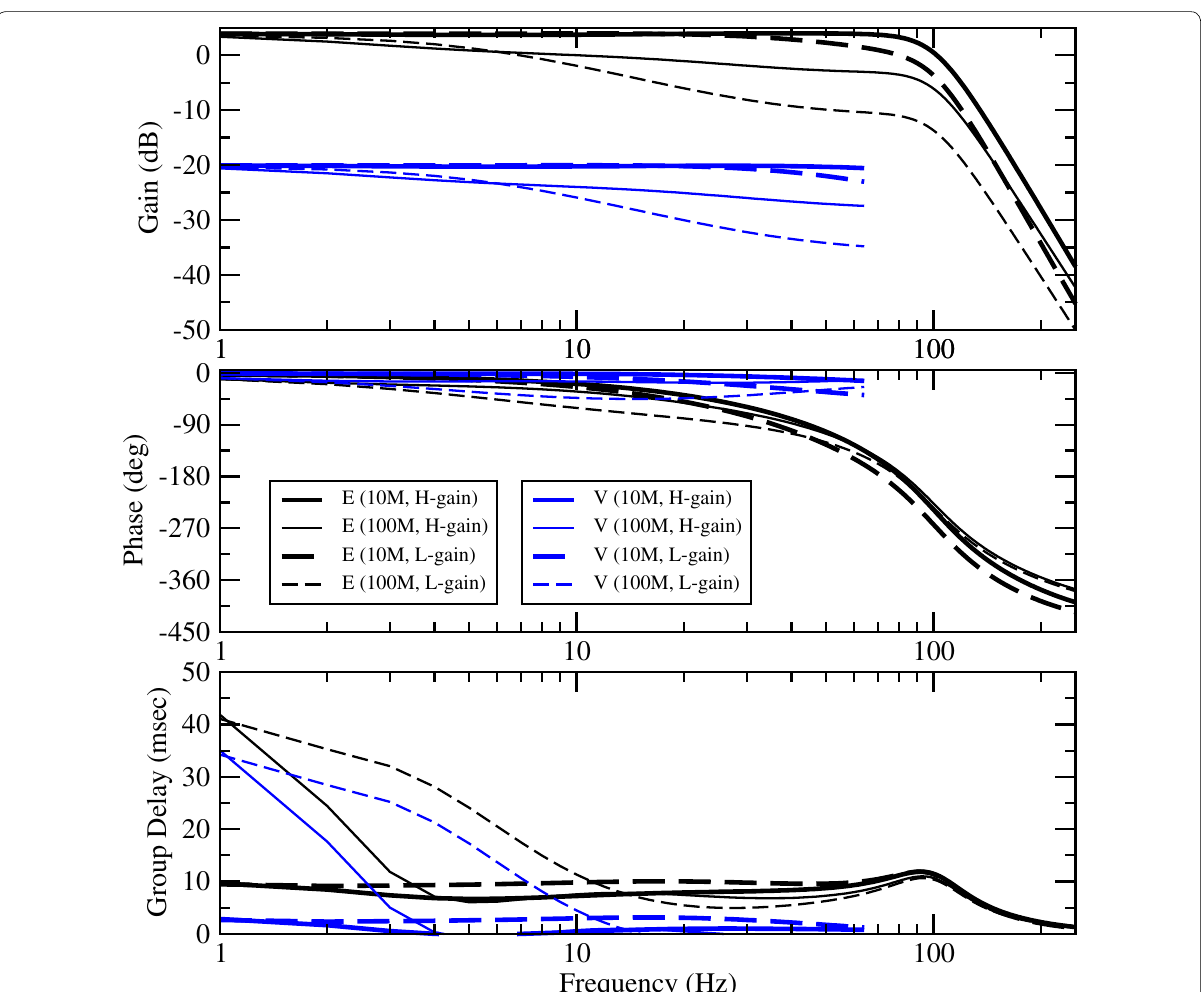
Fig. 6 Assumed gain and phase characteristics of the WPT-Pre (DC) and EFD systems. From the top, gain, phase, and phase delay curves are shown in the frequency range of 1–256 Hz. Black lines indicate the differential electric field channels ( E u and E v ), which include the low-pass filter with a cutoff frequency of 100 Hz. Blue lines indicate the potential channels ( V u1 , V u2 , V v1 , and V v2 ), which directly reflect the characteristics of WPT-Pre (DC). The thick and thin lines indicate plasma resistance of ~ 10 and ~ 100 MΩ, respectively. Normal and dashed lines indicate the WPT-Pre (AC) H-gain and L-gain,